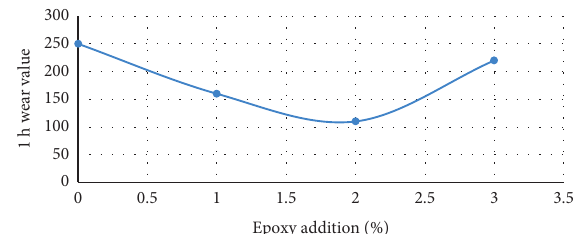
Figure 2: Test results of water-based epoxy resin and waterborne epoxy curing agent.